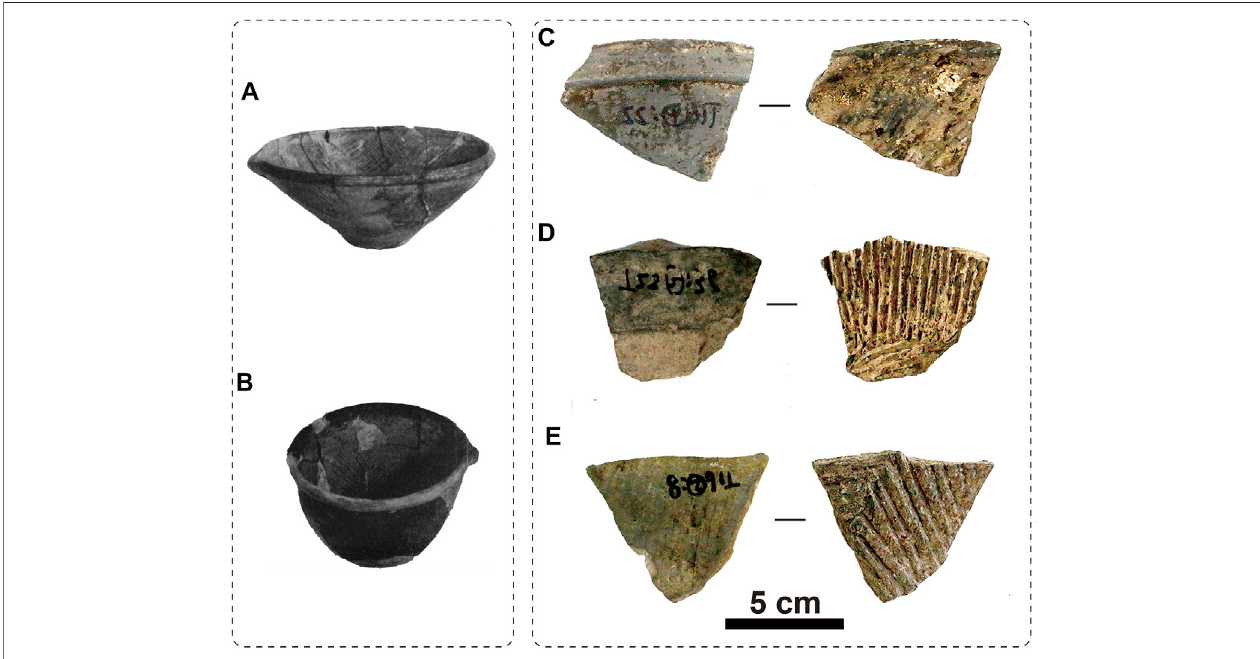
FIGURE 2 | Typical grooved pottery vessels and potsherds from the Meishan site. (A,B) Two types of the grooved vessels at the Meishan site, taken in the 1970s, withoutascalebar(Fang,1975). (C,D) Imagesforexterior(left)andinterior(right)facesofthreesampledpotsherdsinthisstudy. (C) Potsherdwithveryshallowgrooves. (D) Potsherd with deep grooves, ~0.2 cm in depth. (E) Potsherd bearing cross grooves, ~0.1 cm in